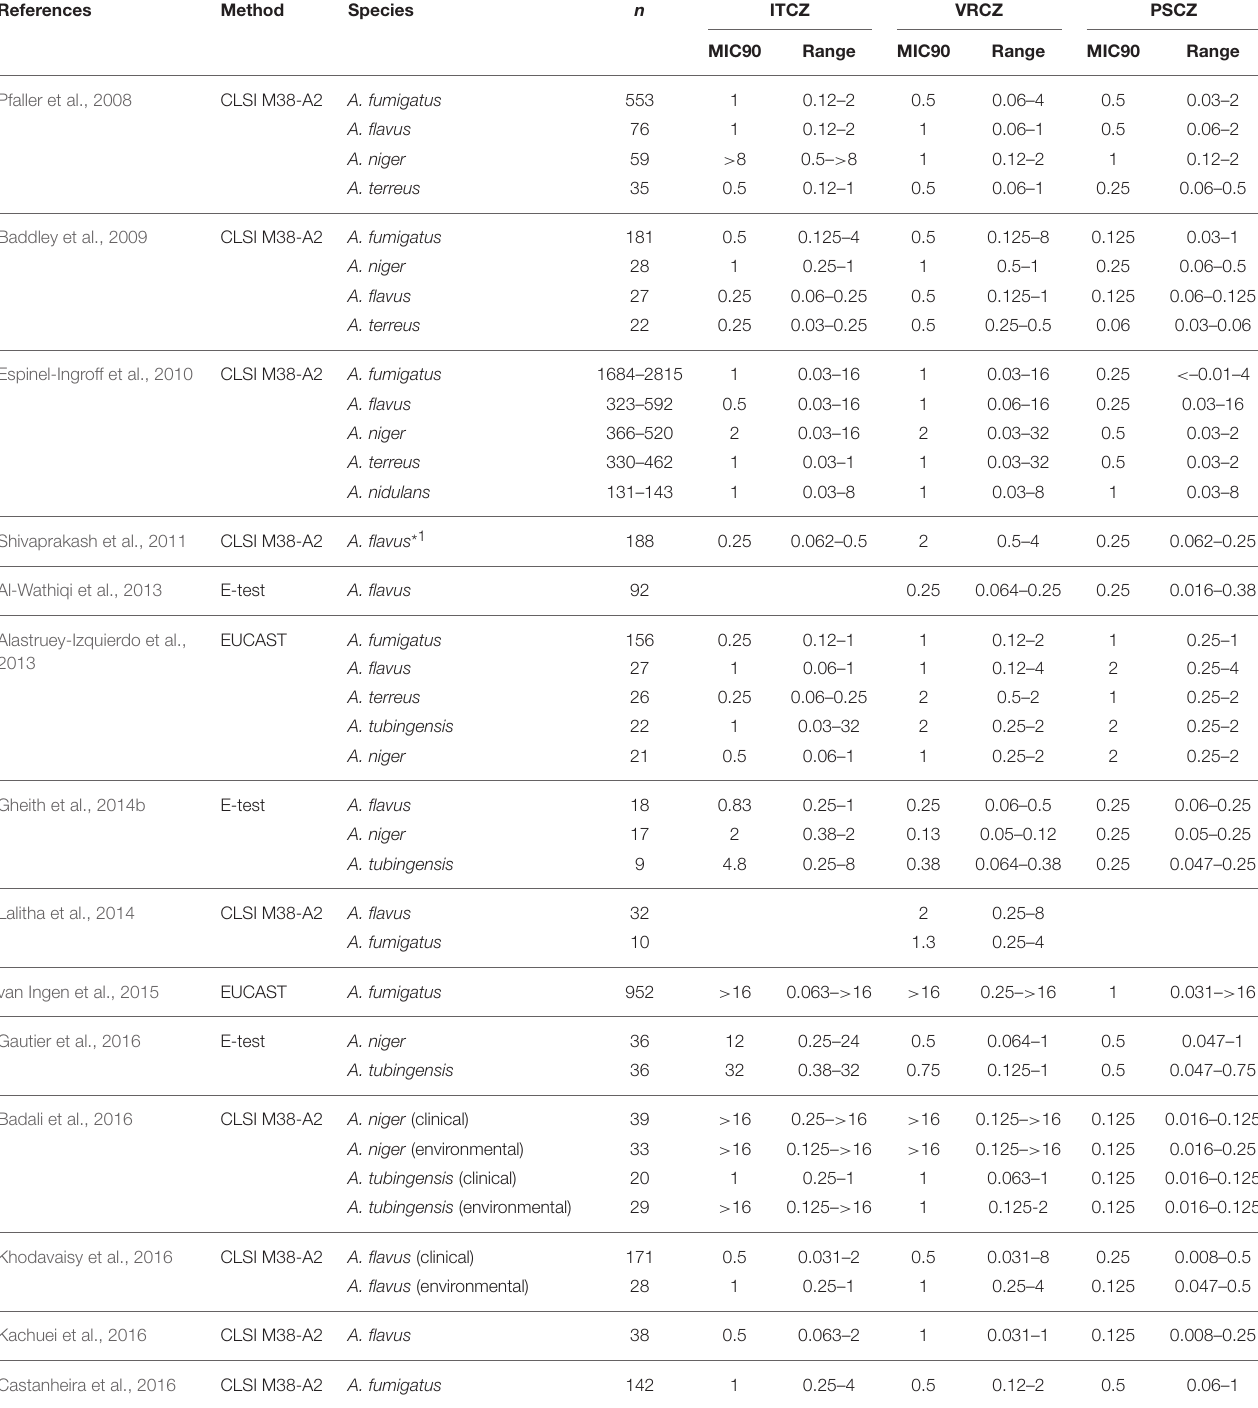
TABLE 1 | Summary of recent reports on azole-resistant Aspergillus species